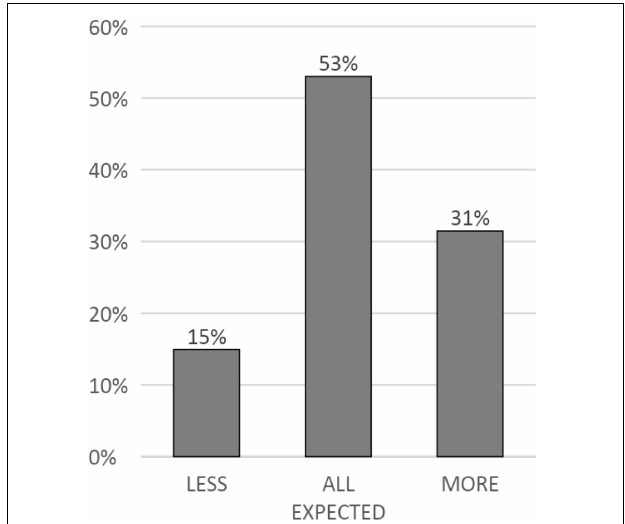
Table 1 provides a summary of the children’s demographic